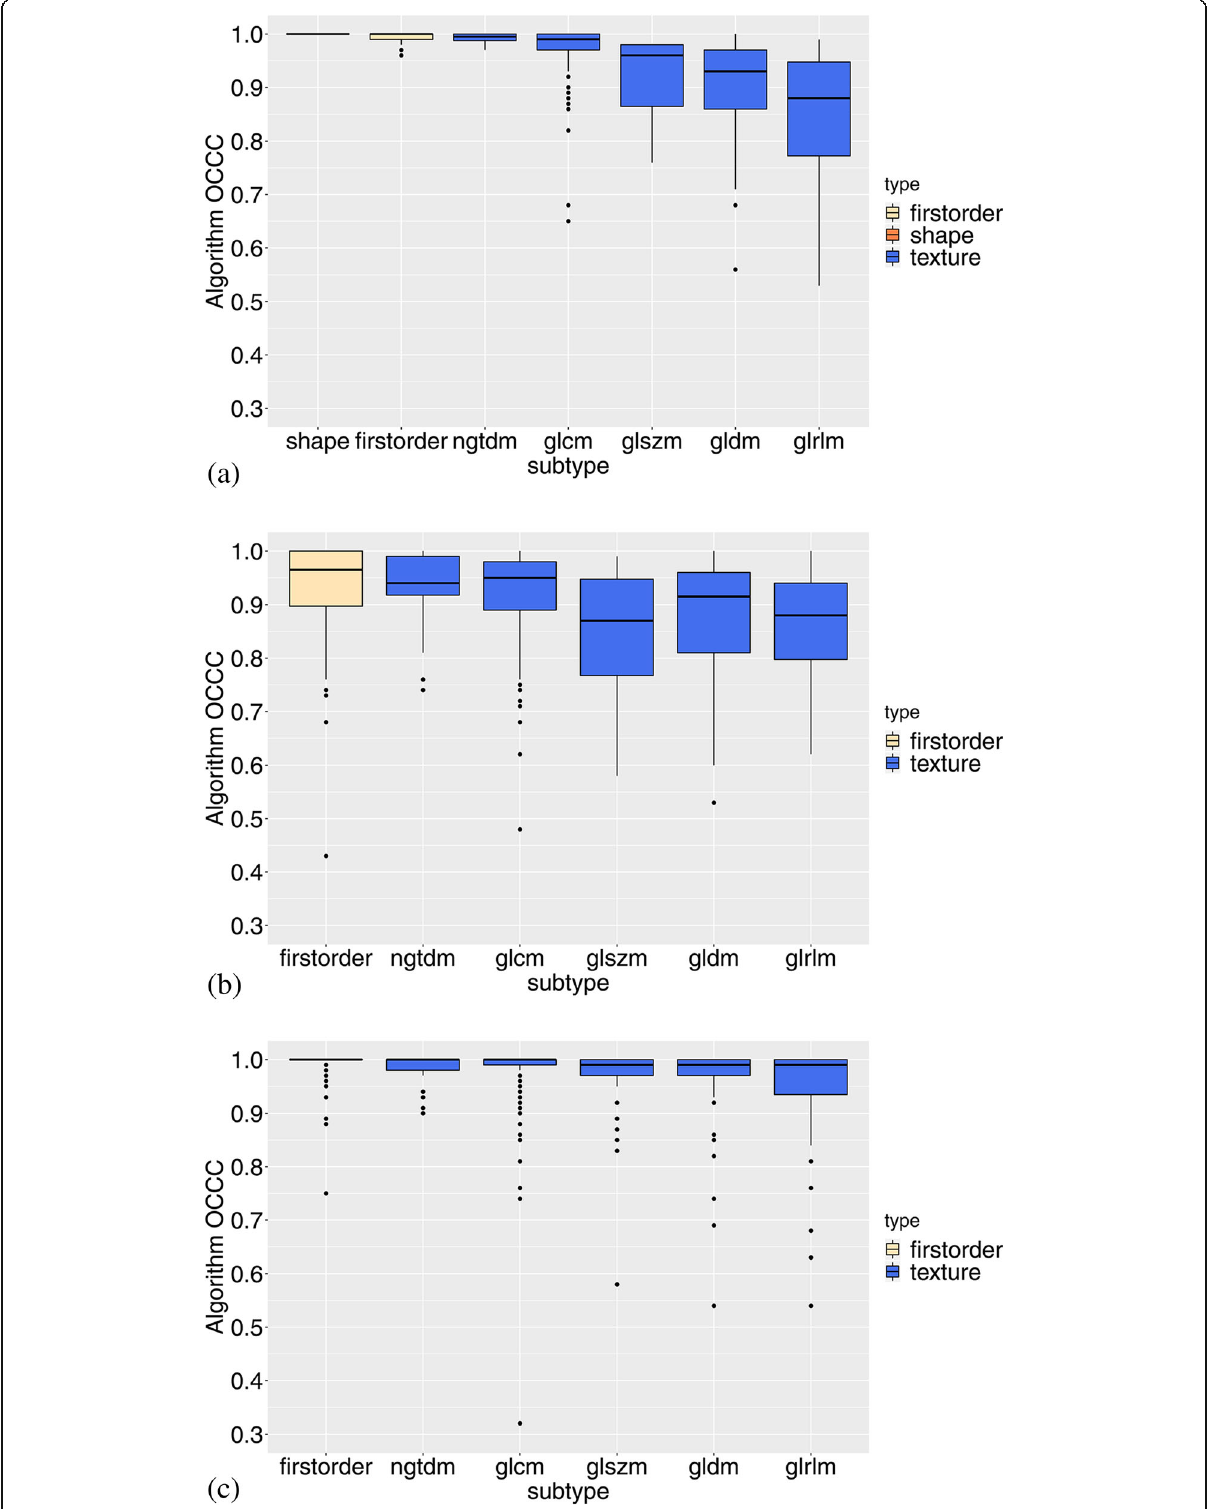
Fig. 2 Overall concordance correlation coefficient (OCCC) among the different reconstruction algorithms. The OCCC is plotted within each subtype of feature and for feature extracted from the original images ( a ), and the wavelet- ( b ) and LoG-filtered ( c )